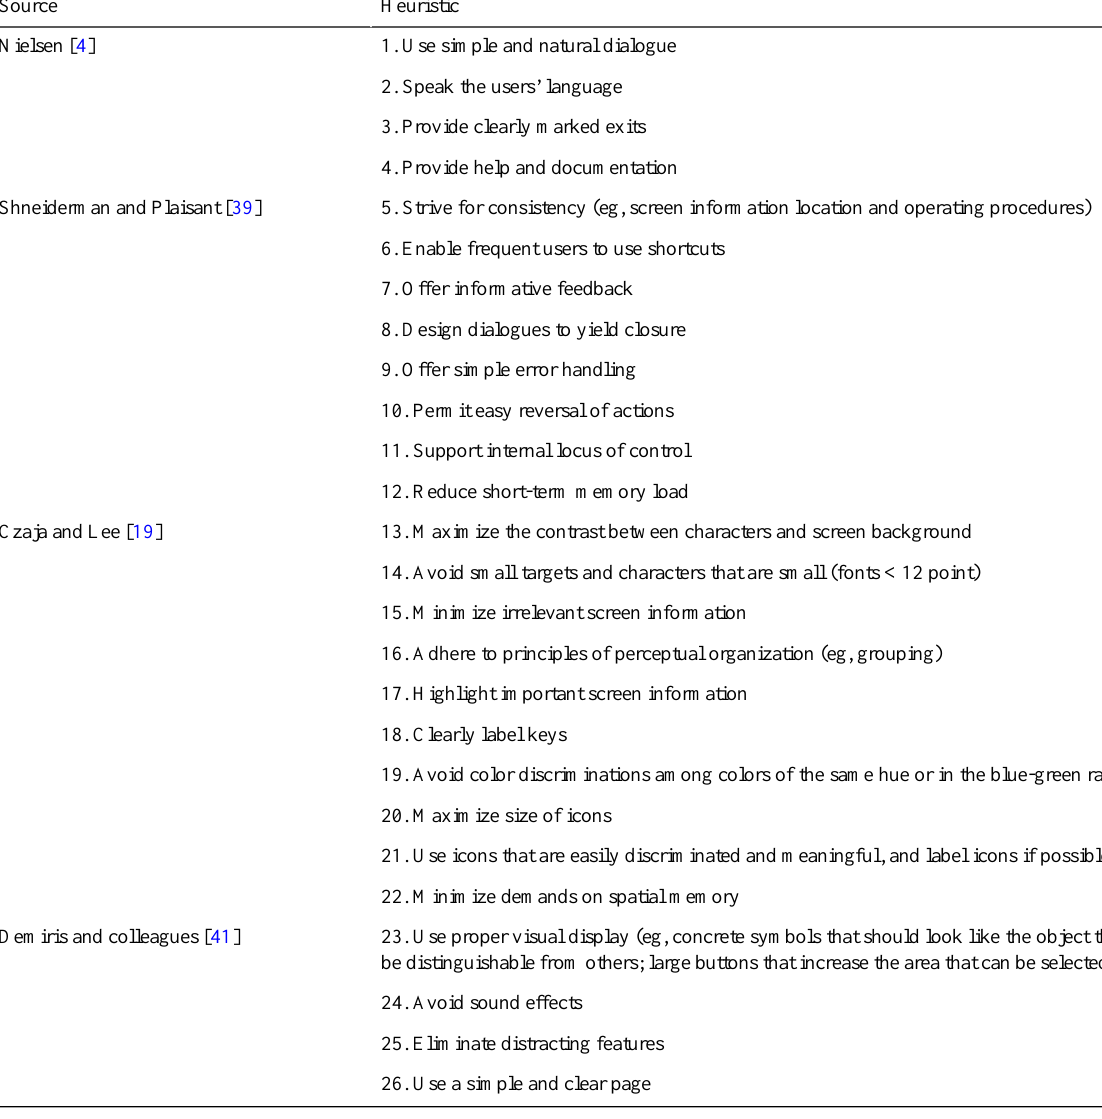
Table 1. The 26 human factors design heuristics used in the heuristics evaluation.